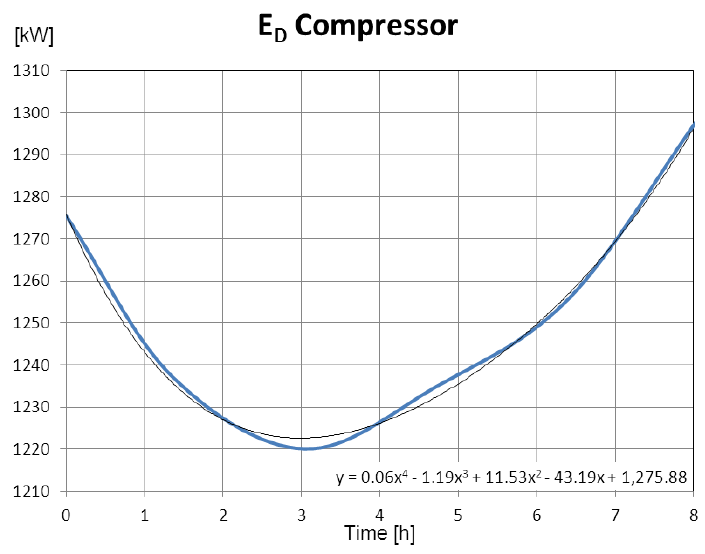
Figure 11. Time history of calculated compressor exergy